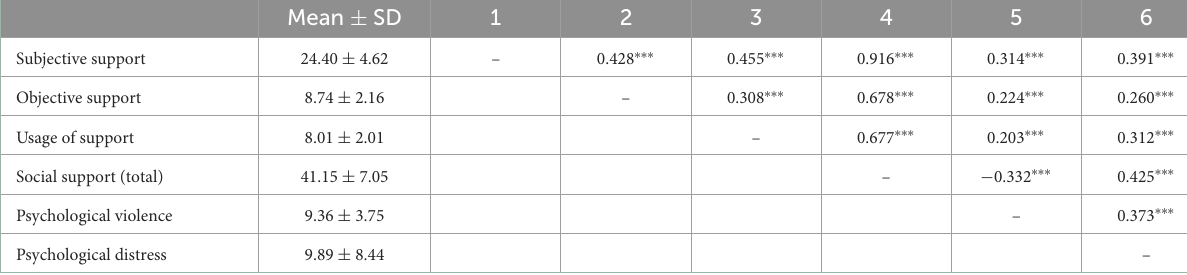
TABLE 2 Descriptive and bivariate correlation analysis for social support, psychological violence, and psychological